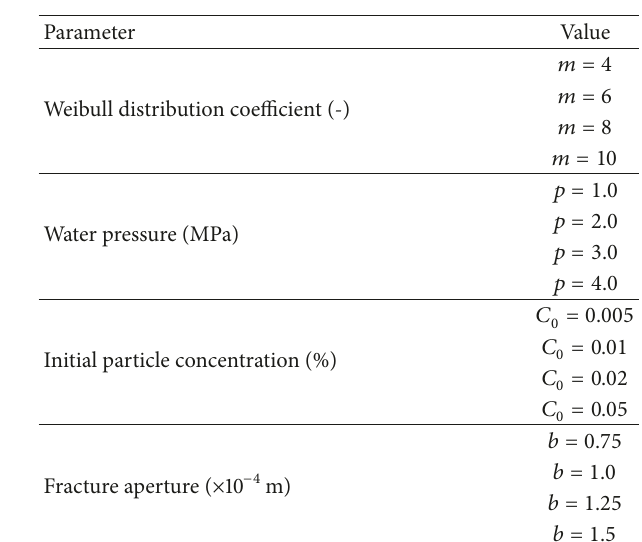
Table 2: List of simulation